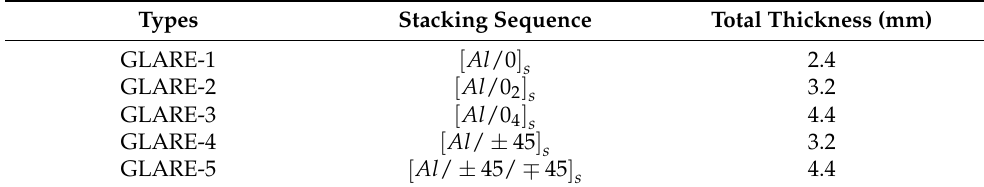
Table 1. Manufactured FMLs with different stacking sequences.